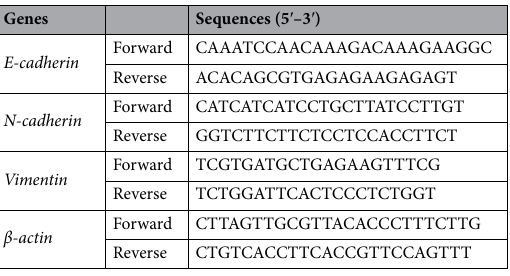
Table 1. Primers used for real time